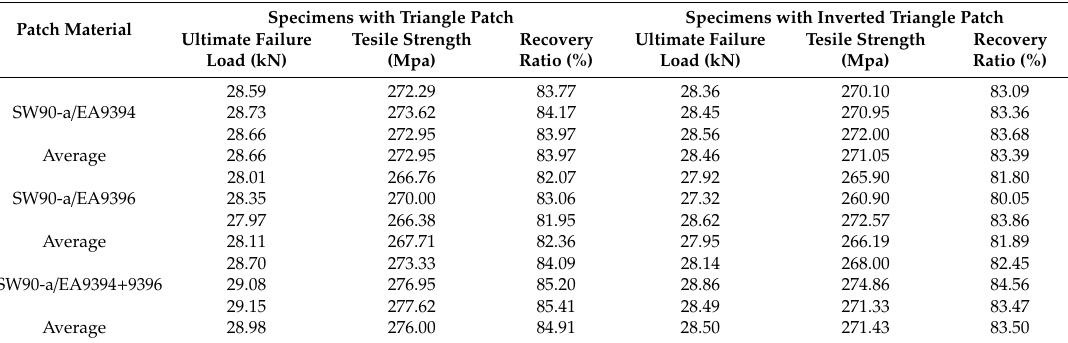
Table 2. Tensile strength and repair recovery ratio of the GFRP-repaired plates.